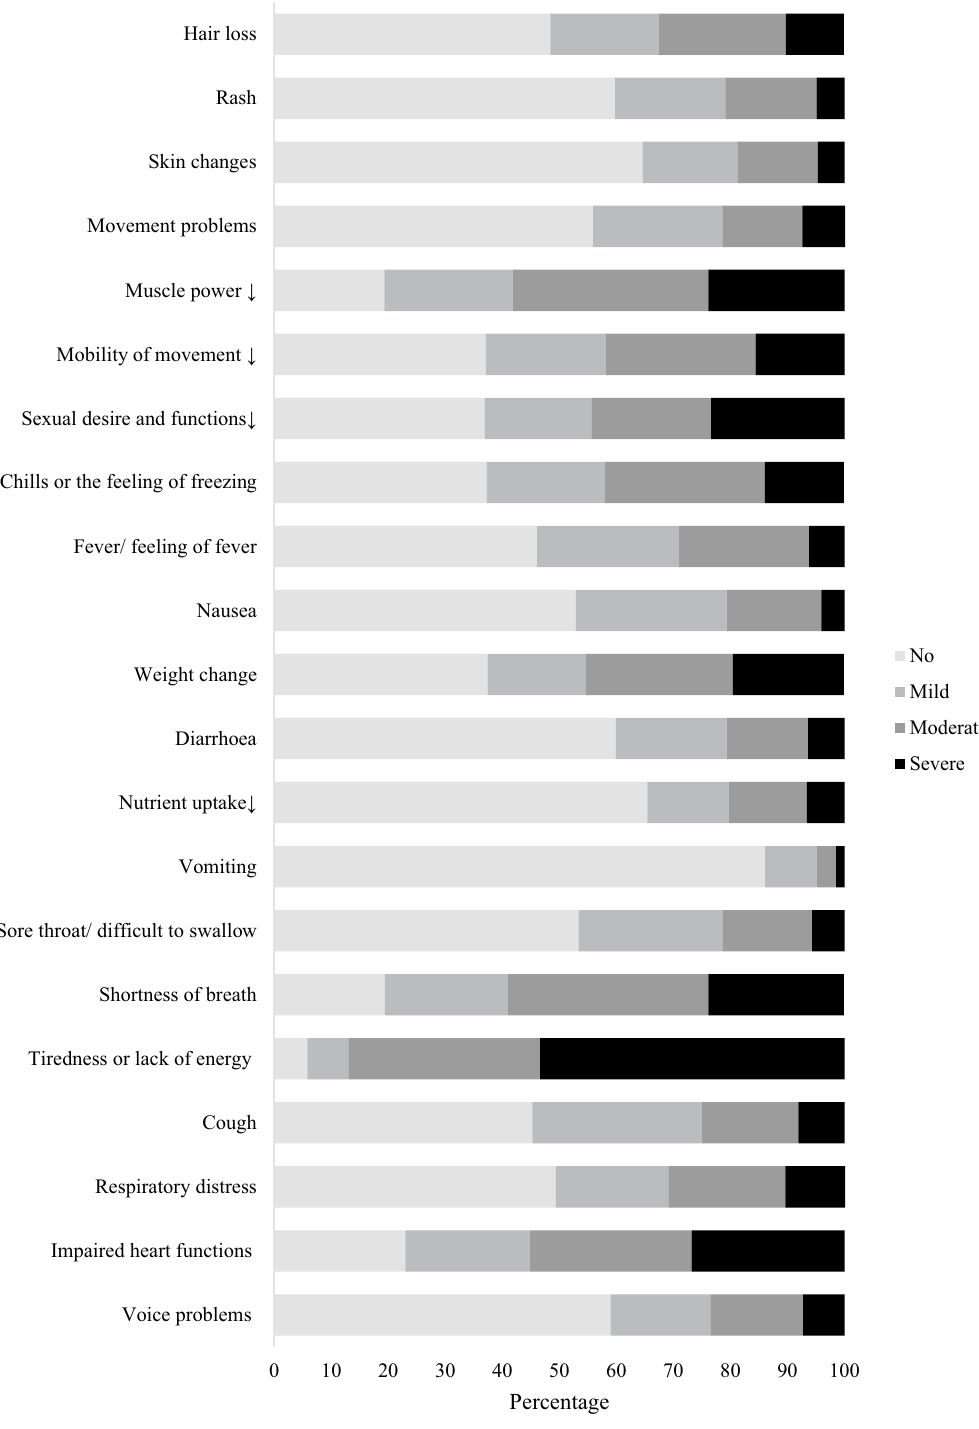
Figure 3. Proportions reporting impairments in body system